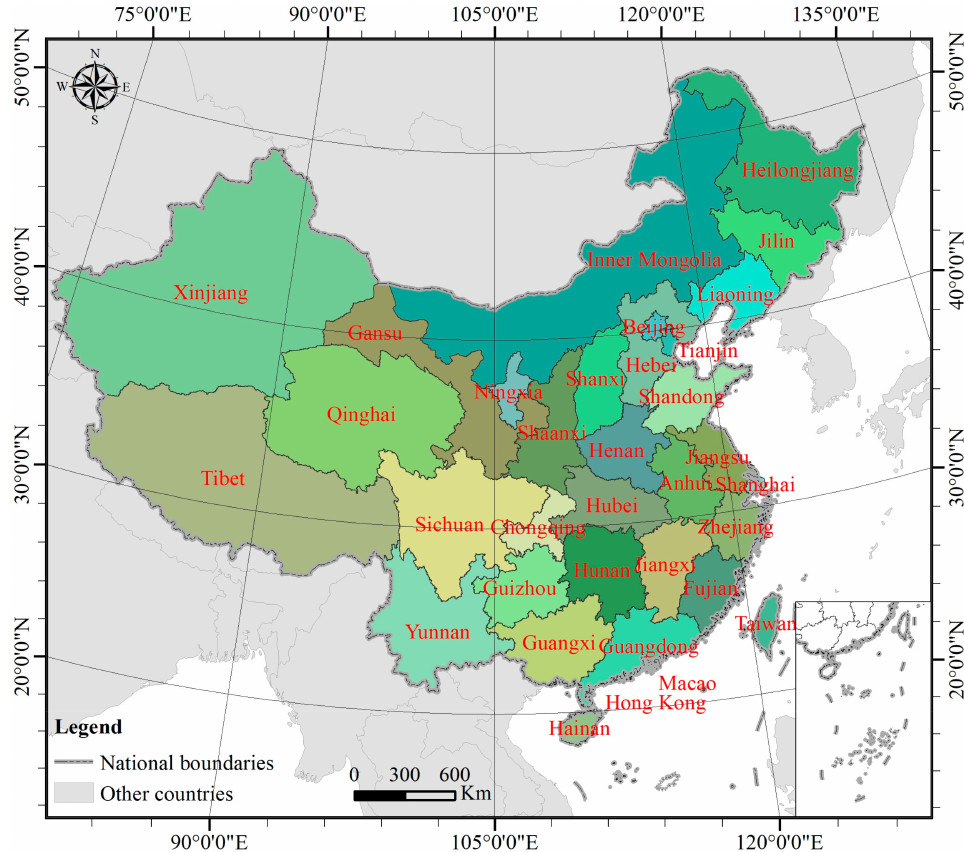
Figure 1. Administrative map of the study area. (Source: made by